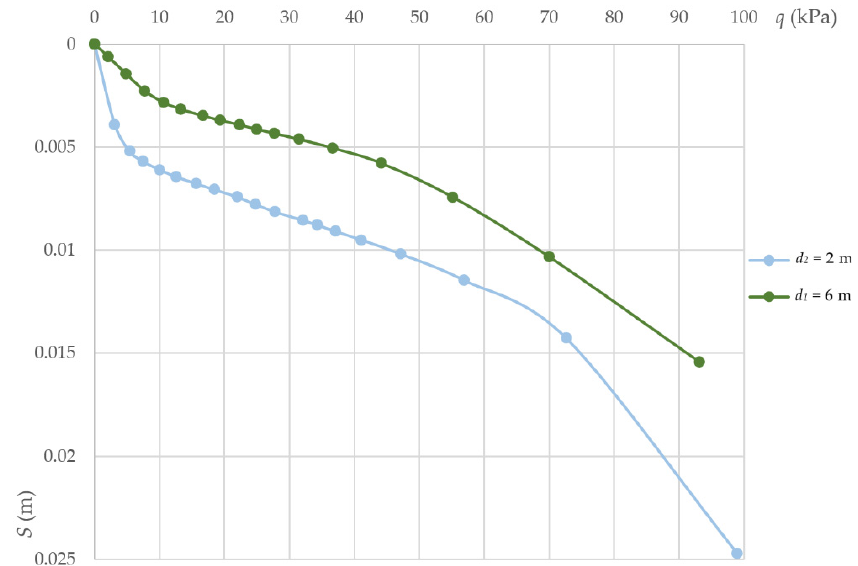
Figure 7. The dependency curves for the total settlement S of the load q calculated with Equations (20) and (21) with various distances d 1 = 6 m and d 2 = 2 m between the fence wall and the point of application of the distributed load.